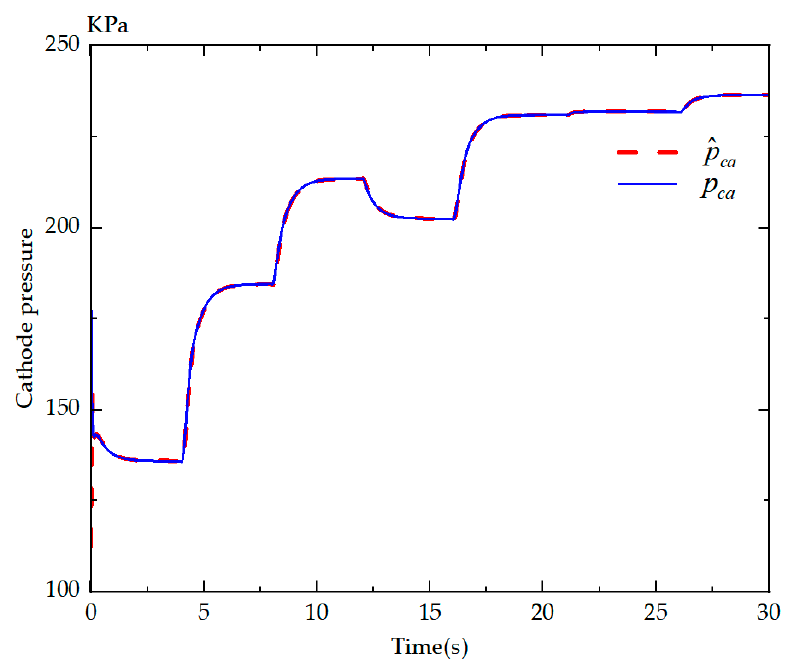
Figure 2. Actual and estimated values of cathode pressure under load changes. The biggest difference between the estimated cathode pressure by ESO and the actual cathode pressure, as shown in Figure 3, is approximately 2200 Pa, which is within the permitted range. The OER can be reconstructed using cathode pressure estimated by the ESO, and the compressor input voltage is controlled by using reconstructed OER.